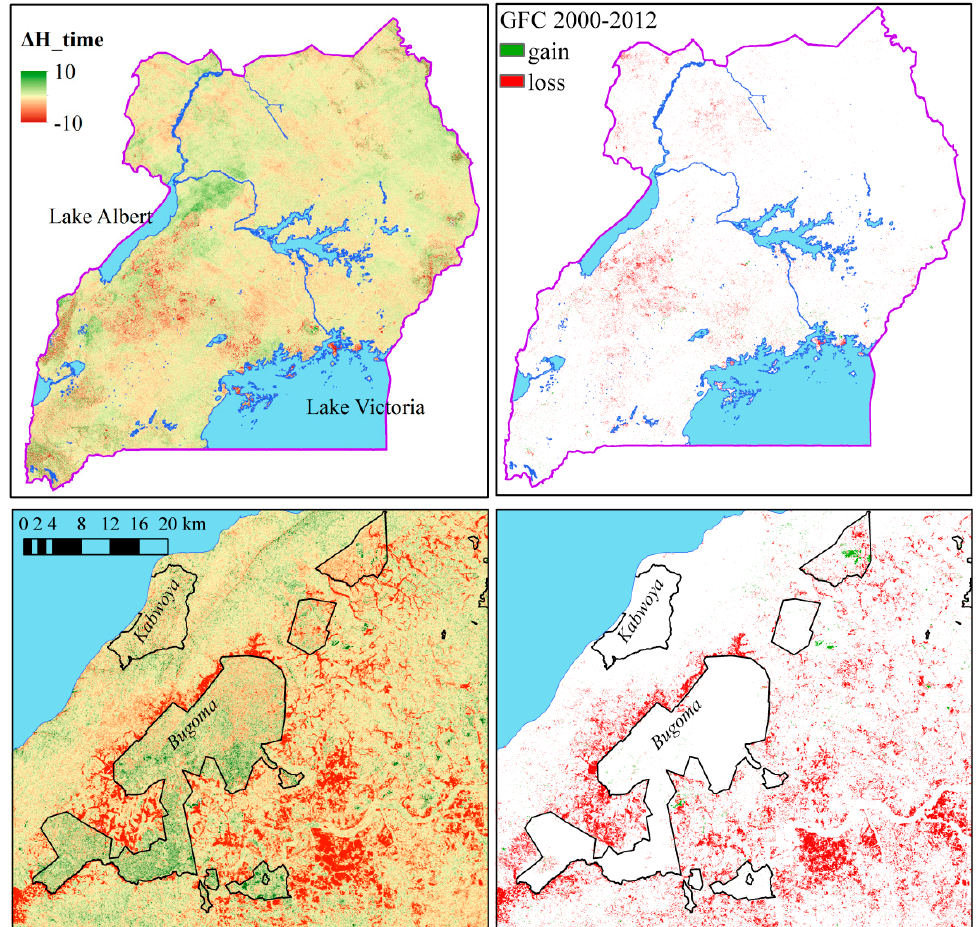
Figure 6. Changes in forest height based on InSAR DEMs (left) and in forest cover based on Landsat (right) from 2000–2012 [9], where the upper panels show results for the entirety Uganda and lower panels for an area around the Bugoma protected forest in the western part. The white areas in the right panels represent no change.